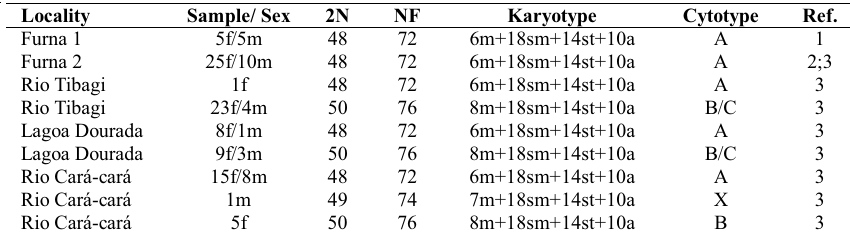
Table 1. Karyotypic characteristics of the populational samples of Astyanax aff . fasciatus from Furna 2, rio Tibagi, Lagoa Dourada and rio Cara-cará. 2N = diploid chromossomal number; NF = fundamental number; sex: f = female, m = male; karyo- type: m = metacentric; sm = submetacentric; st = subtelocentric; a = acrocentic; cytotype: X=probable hybrid form. References (Ref.): (1) Matoso et al . (2002); (2) Gross et al. (2004); (3) Present study.